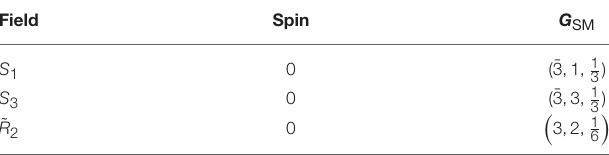
TABLE 10 | Quantum numbers of